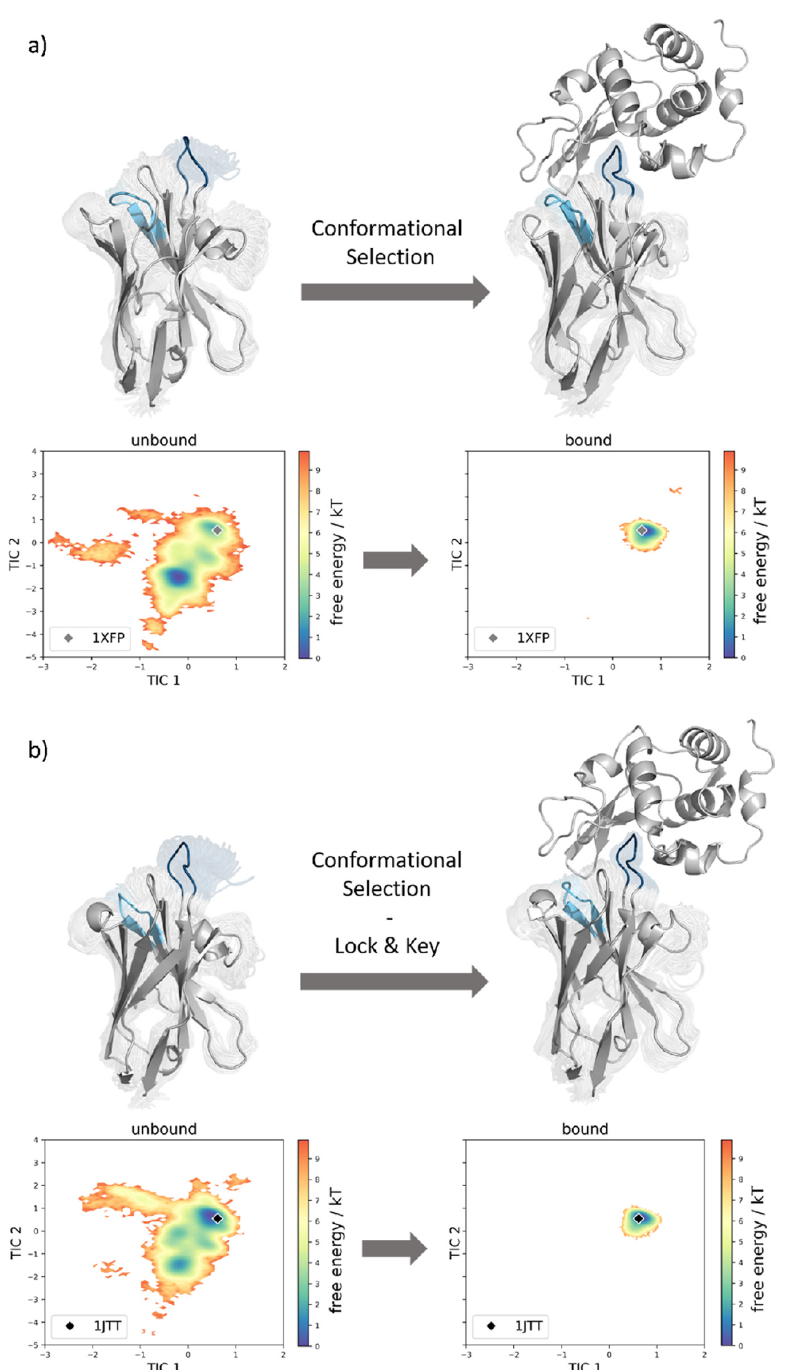
Figure 6. ( a ) Comparison of the structural ensembles resulting from 64.2 µ s and 29.0 µ s cMD simulation trajectories by simulating the structure with the PDB accession code 1XFP with and without the antigen present. By clustering on the 3 CDR loop, we obtained 321 and 145 clusters, respectively. Next to the structures, the conformational tICA spaces are shown, from which a substantial rigidification is noticeable. ( b ) Comparison of the structural ensembles resulting from 48.0 μ s and 35.8 μ s cMD simulation trajectories by simulating the structure having PDB accession code 1JTT without and with antigen present. From the clustering on the 3 CDR loops the number of clusters resulted in 240 and 179 clusters, respectively. Next to the structures, the conformational tICA spaces are shown, from which a substantial rigidification is noticeable.